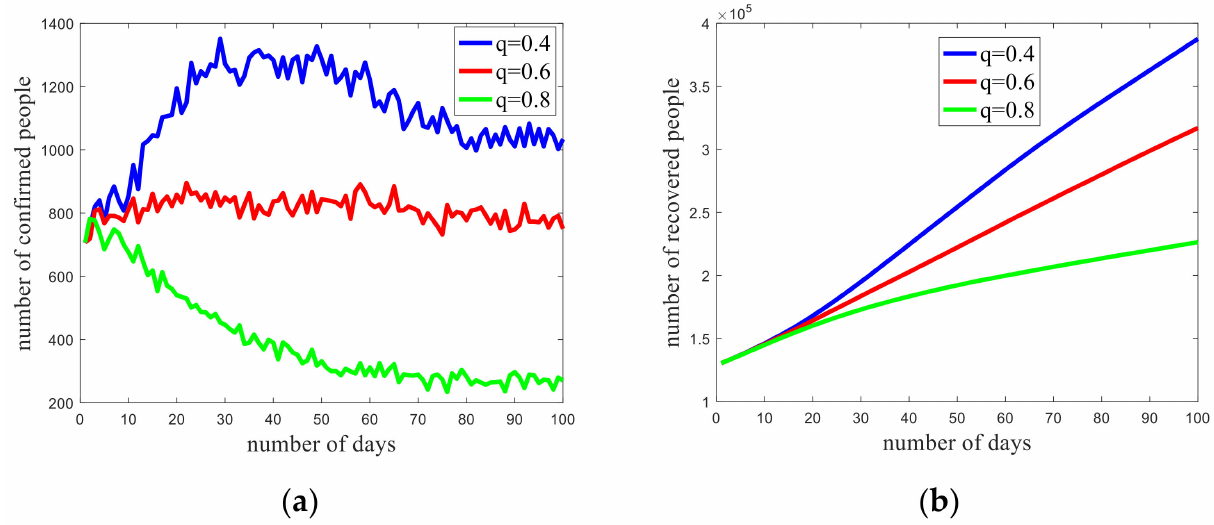
Figure 6. ( a ) Simulation results of Iowa under different self-isolated proportions ( q ). ( b ) The trend of recovered number under different self-isolated proportions ( q